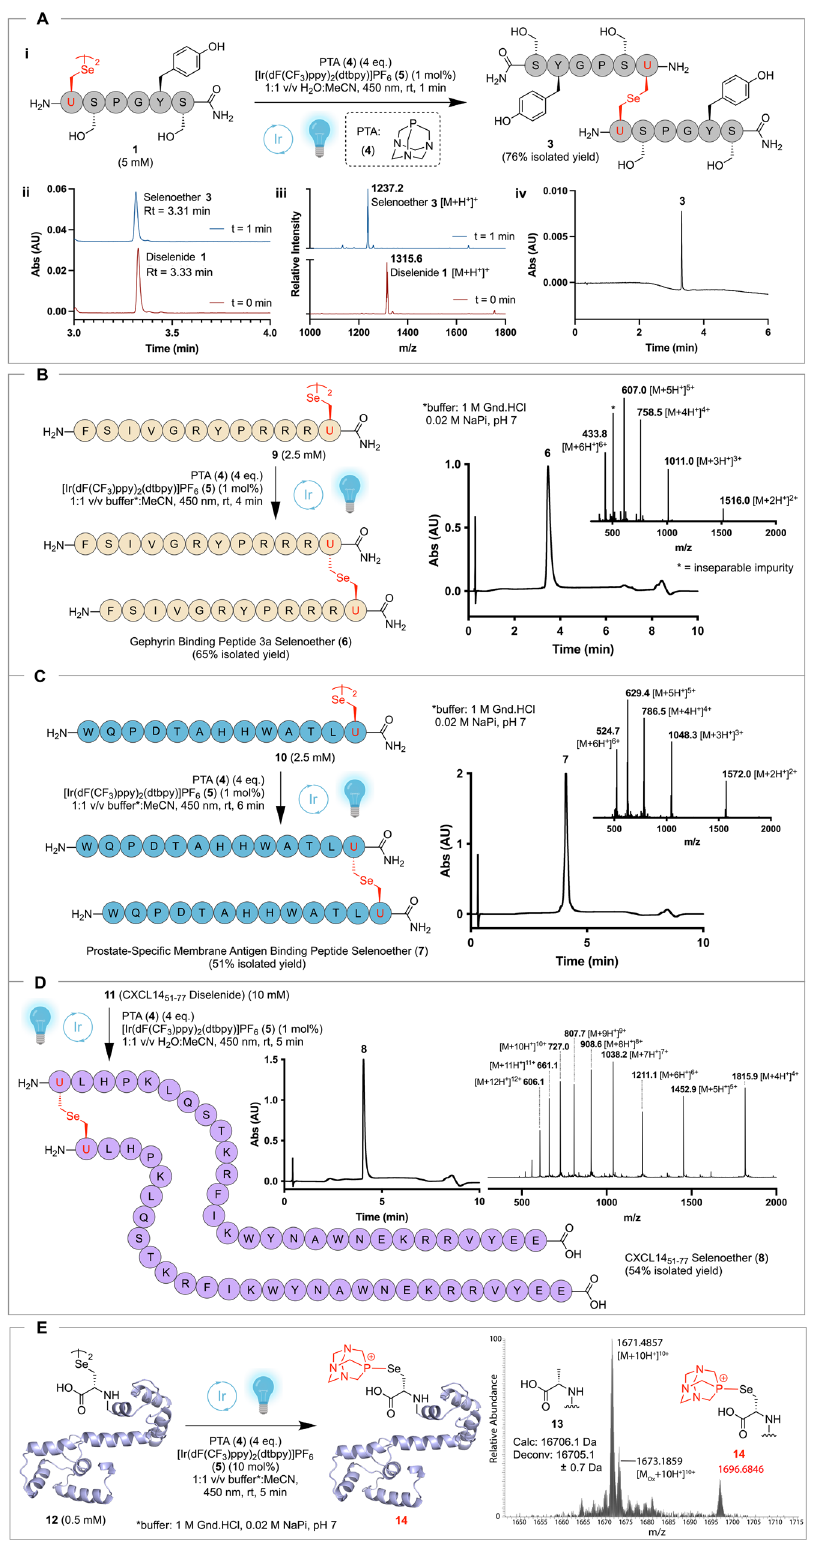
Fig. 1 | Dimerization of selenopeptides via the PDC reaction. A Optimization of the PDC dimerization reaction on [H 2 N-USPGYS-NH 2 ] 2 model peptide 1 . Site- speci fi c PDC dimerization of B Gephyrin Binding Peptide 3a diselenide 9 ; C Prostate-Speci fi c Membrane Antigen (PSMA) Binding Peptide diselenide 10 ; D CXCL14 51-77 diselenide 11 to afford the reductively stable selenoether-linked peptide dimers 6 – 8 . Analytical HPLC and ESI-MS of the puri fi ed selenoether